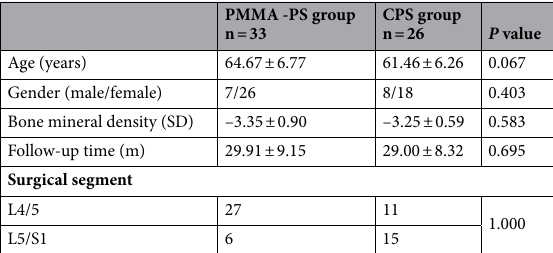
Table 1. Basic data of two groups of